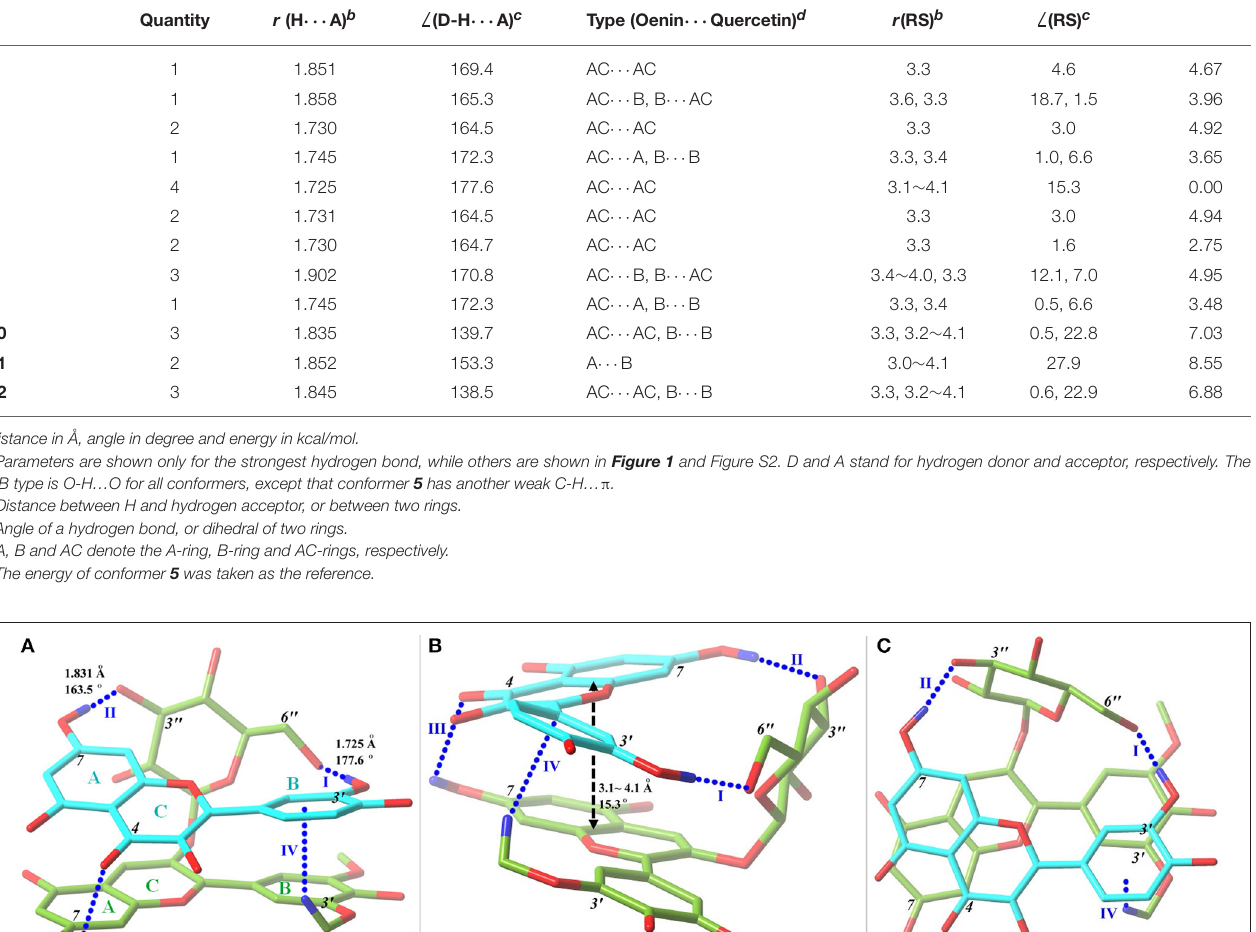
TABLE 1 | Main parameters for HB and ring-stacking (RS) and relative Gibbs free energies 1 G relative for the examined conformers.